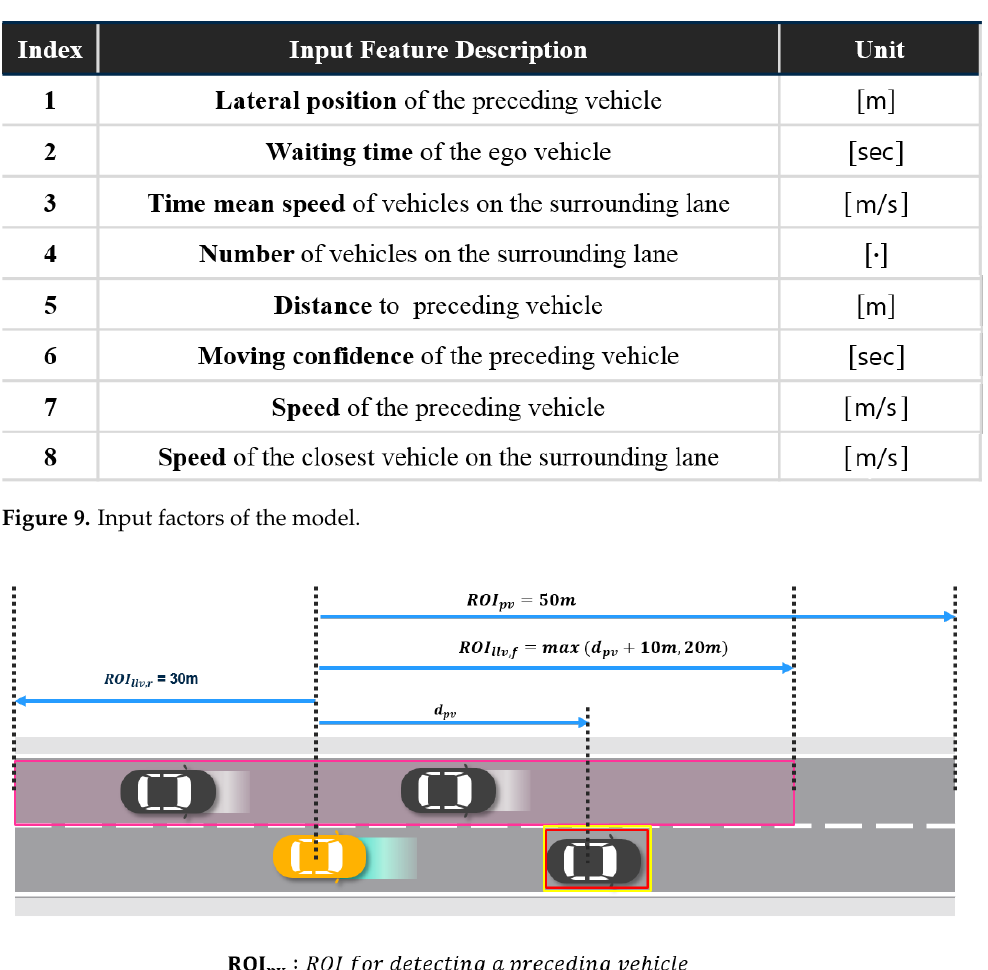
Figure 10. Region of interest in multi-lane environments. While ROIs for detecting a preceding vehicle and rear vehicles on the left lane are determined by the constant values, ROI for detecting front vehicles on the left lane depends on the distance to the preceding